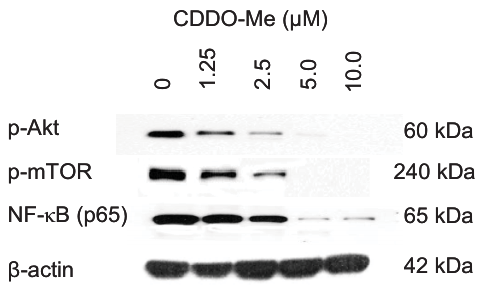
Figure 2. CDDO-Me inhibits antiapoptotic p-Akt, p-mTOR and NF-(cid:2)B in TRAMPC-1 cells. TRAMPC-1 cells were treated with CDDO-Me (0–10 (cid:5)M) for 24 h and levels of p-Akt, p-mTOR and NF-(cid:2)B (p65) were analyzed by Western